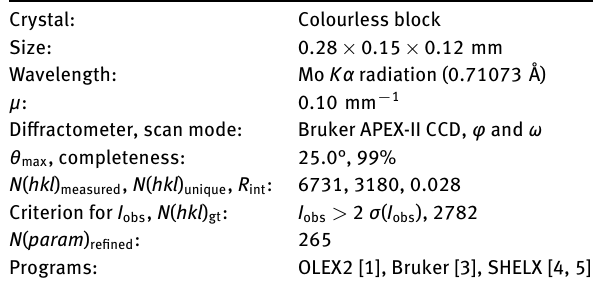
Table 2: Fractional atomic coordinates and isotropic or equivalent isotropic displacement parameters (Å 2